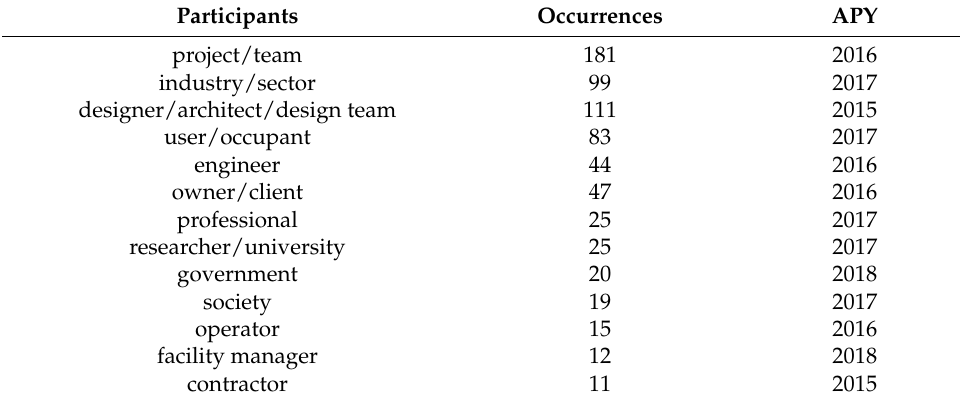
Table 6. Participants in the topic of BIM and building energy efficiency analysis.